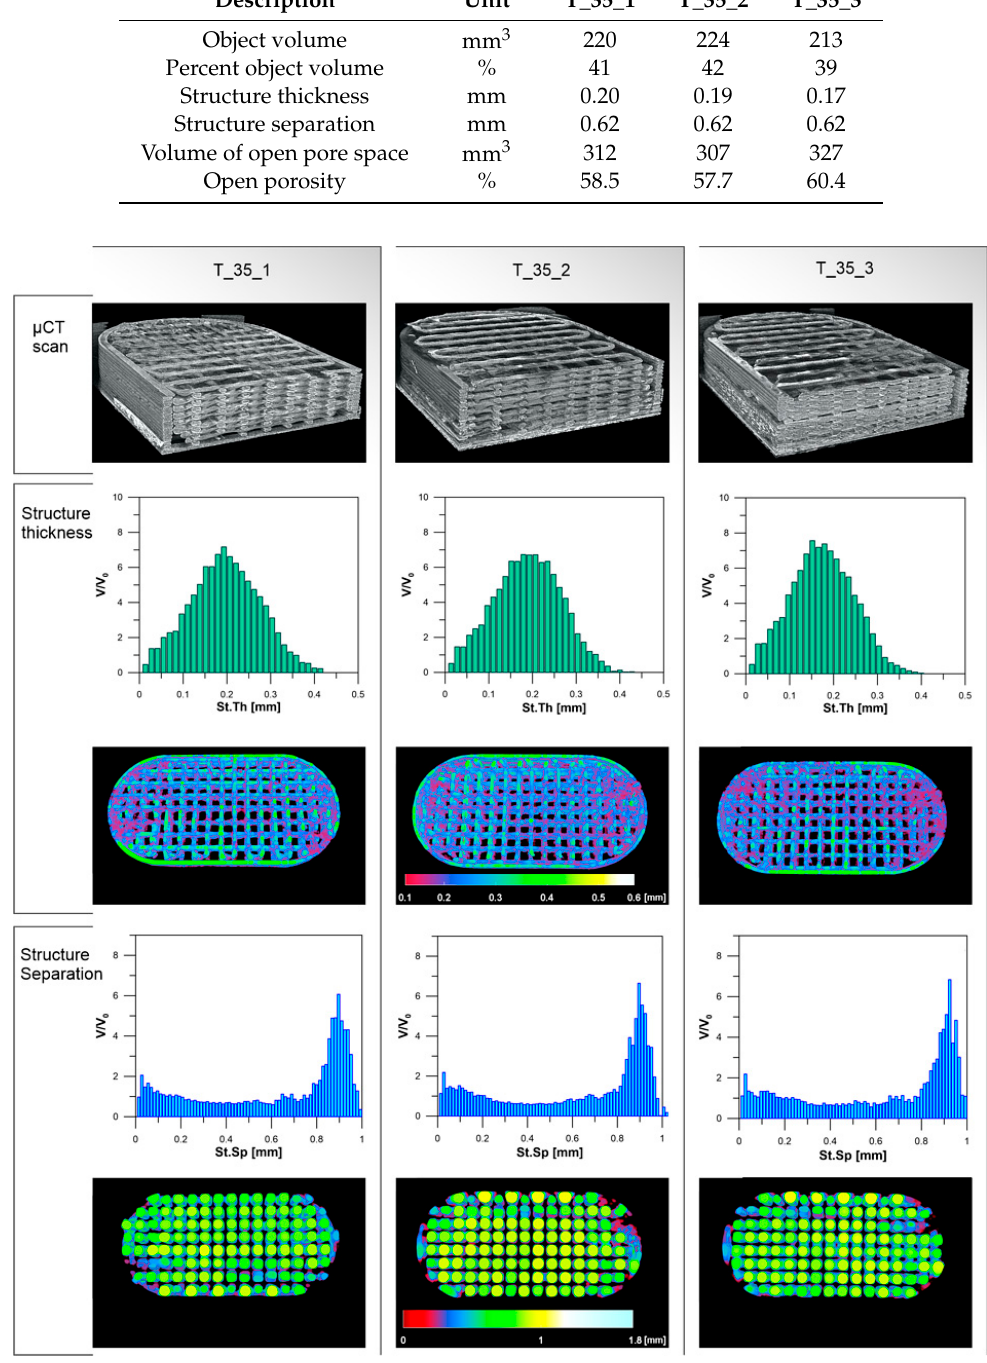
Figure 7. Comparison of 3DP tablets with 35% of infill.